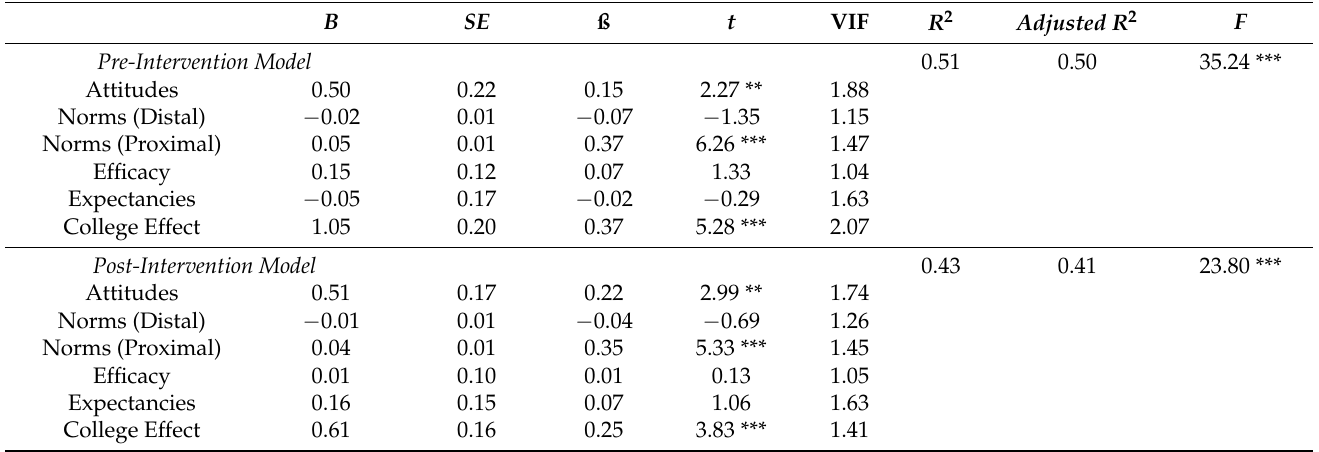
Table 2. Final pre- and post-intervention regression models predicting drinking